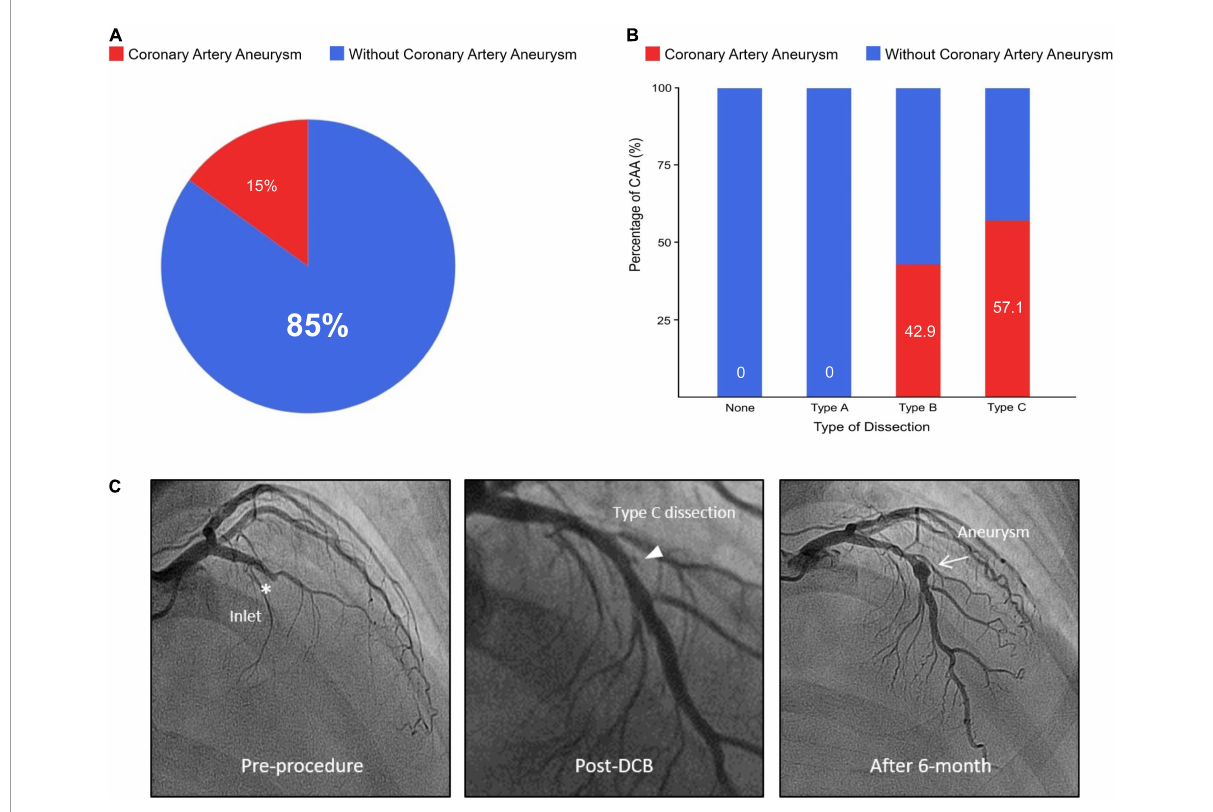
FIGURE1 Percentage of coronary artery aneurysm according to dissection type after DCB treatment and representative case. (A) Proportion of aneurysm in dissection following DCB treatment. (B) Relationship between dissection type and percentage of CAA. (C) A representative case of 56-year-old male with stable angina. His only coronary risk factor was a family history of coronary artery disease. His coronary angiography shows a chronic total occlusion of left anterior descending artery. After successful pre-balloon angioplasty, the lesion was treated with a 3.5 × 20 mm DCB, and the DCB to reference vessel ratio was 1.2. After DCB treatment, there was a 17% residual diameter stenosis with normal antegrade flow and type C dissection at the inlet site of chronic total occlusion. Six-month later, follow-up angiography confirmed a